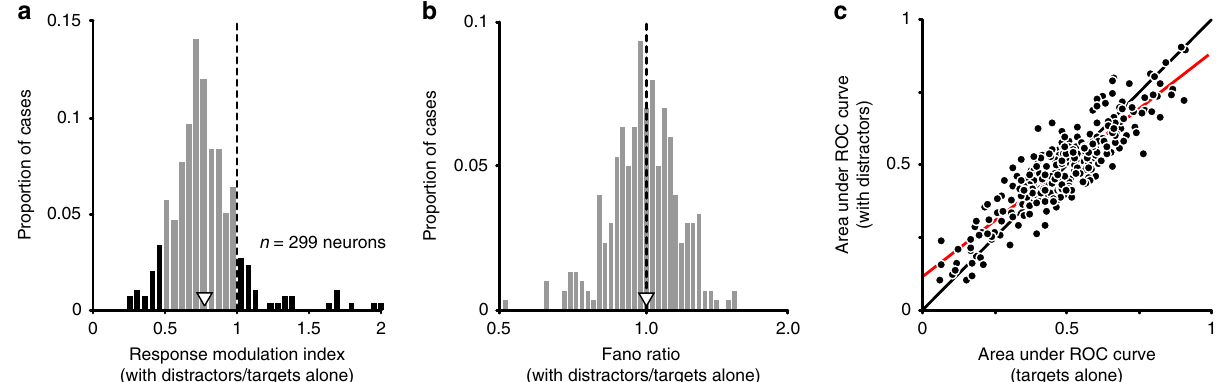
Fig. 5 How distractors affect V1 neuronal responses to targets. a Effect on responsivity. Histogram shows the response modulation index (the average response to targets with distractors compared to targets alone). Shaded black tails indicate cases with particularly strong suppression (index ≤ 0.5) or with facilitation (index ≥ 1). Open arrowhead indicates mean. b The Fano factor for targets with distractors, relative to targets alone. Open arrowhead indicates mean. c Single neuron discriminability (area under ROC curve) for target stimuli separated in orientation by 20 degrees, for targets alone and with distractors. Unity line shown in black; red line represents linear regression line. Source data are provided as a source data fi